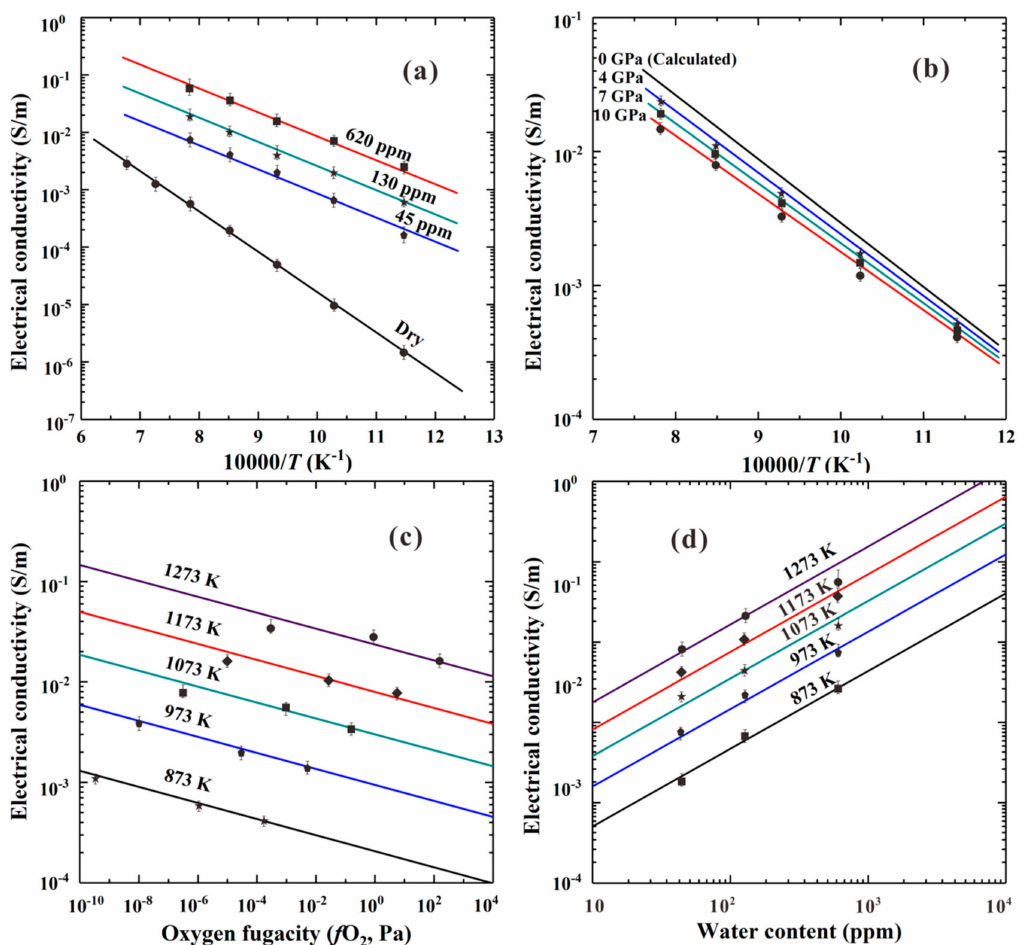
Figure 6. The influence of ( a ) temperature and water content, ( b ) temperature and pressure, ( c ) oxygen fugacity and temperature, and ( d ) water content and temperature on the EC of hydrous olivine aggregates under HP-HT conditions (873–1473 K and 4–10 GPa). Oxygen fugacity is controlled by three di ff erent solid-state oxygen bu ff ers, increasing along Ni–NiO, Mo–MoO 2 and Re–ReO 2 (Reproduced with permission from Dai and Karato, Phys. Earth Planet. Inter.; published by Elsevier, 2009